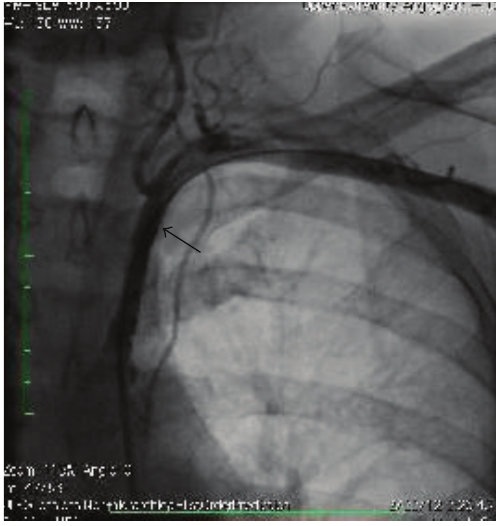
Figure 2: Angiogram after stent placement.